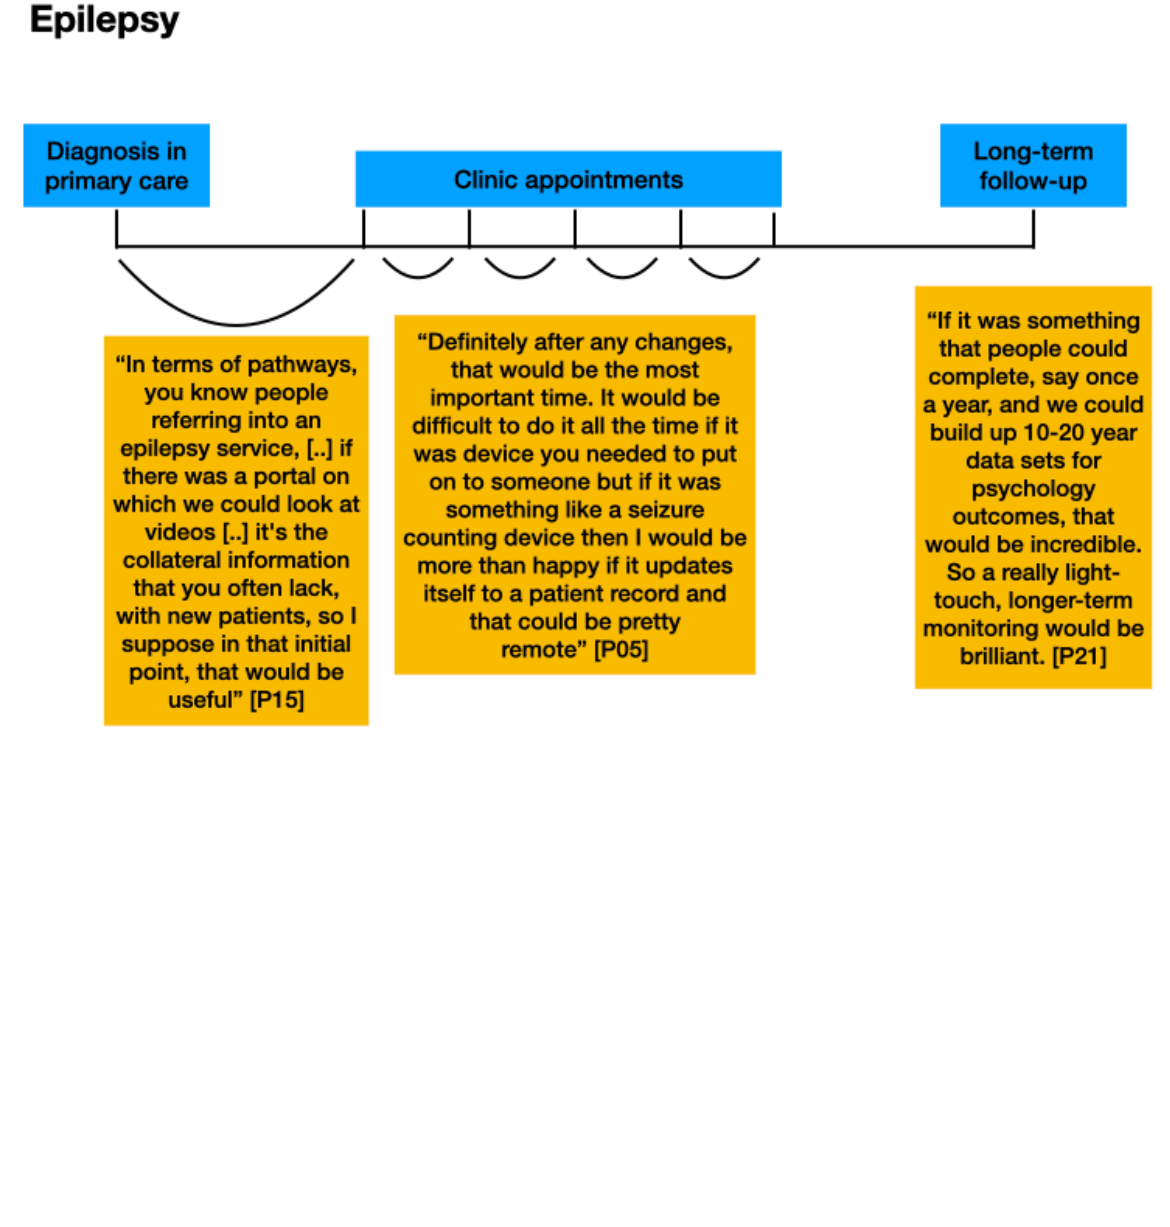
Figure 1. Participants’ comments about the timing of the use of remote measurement technology in the epilepsy care pathway, including monitoring on a yearly basis once stable to allow assessment of follow-up and to create data for future